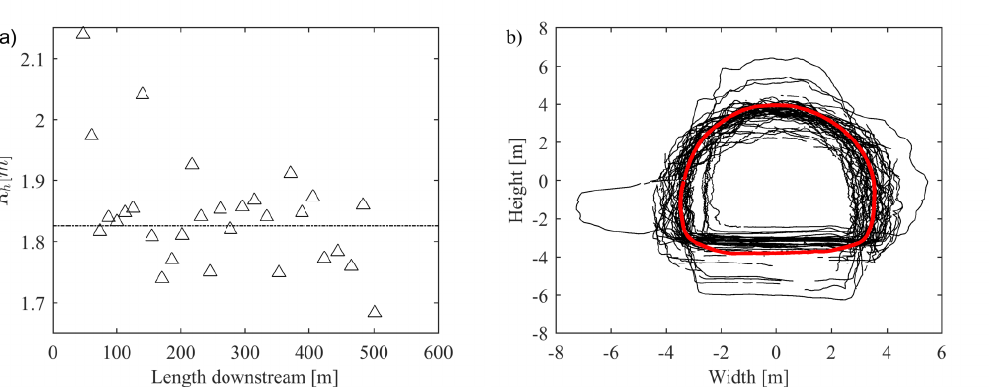
Figure 2. ( a ) The local hydraulic radius as a function of the tunnel length. The black line represents the average. ( b ) 45 cross sections of the tunnel. the red line represent the average cross section. Section 2.2 details the procedure on how to attain data on the cross